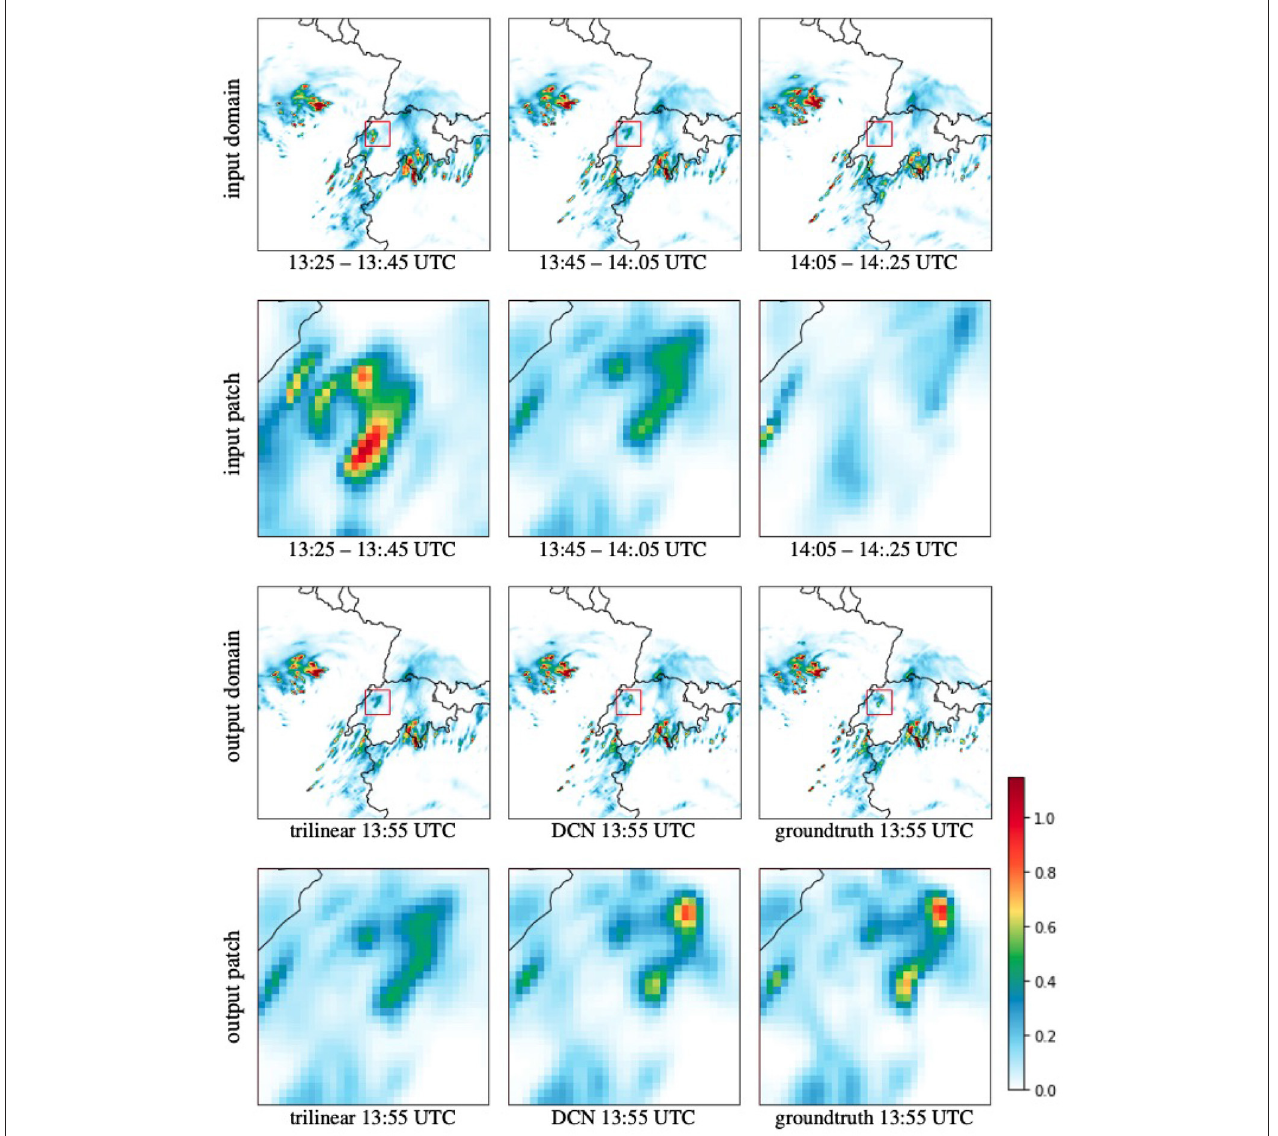
FIGURE 6 | Downscaling results for precipitation (g/m 2 ) by a factor of k t = 4 from 20 to 5 min resolution. The first row shows time steps of the trivially downscaled domain (spatially). The second row shows a patch as it is sent into the network. The third row compares the result of the network to the groundtruth on the full domain. The last row shows the groundtruth comparison for the patch that was